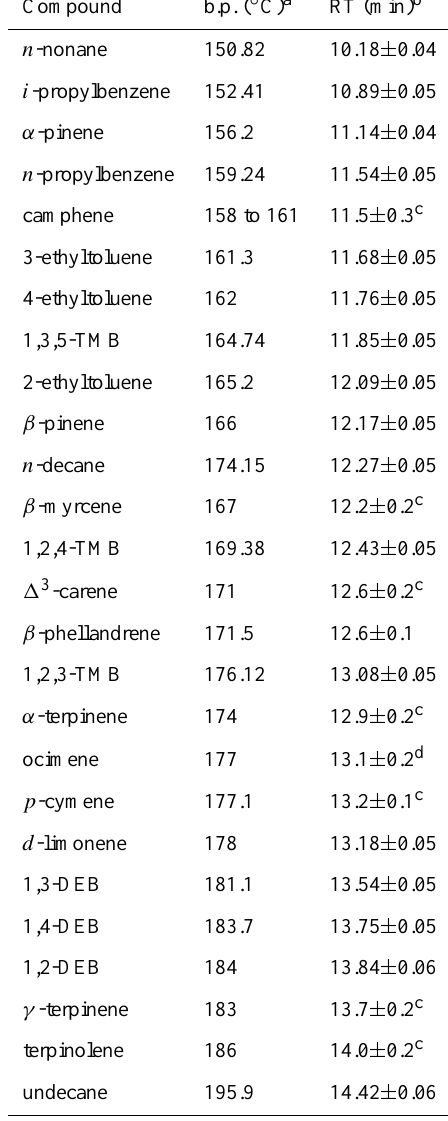
a (Lide, 2008). b Measured average ± 3 σ except where noted oth- erwise. c Derived from linear regression between RT and b.p. for compounds in the primary working standard; errors represent 0.01– 1 ◦ C uncertainty in b.p. values and the 95% prediction interval on the RT values determined from regression analysis. d (Graedel, 1979). Abbreviations: TMB, trimethylbenzene; DEB, diethlylben- zene.